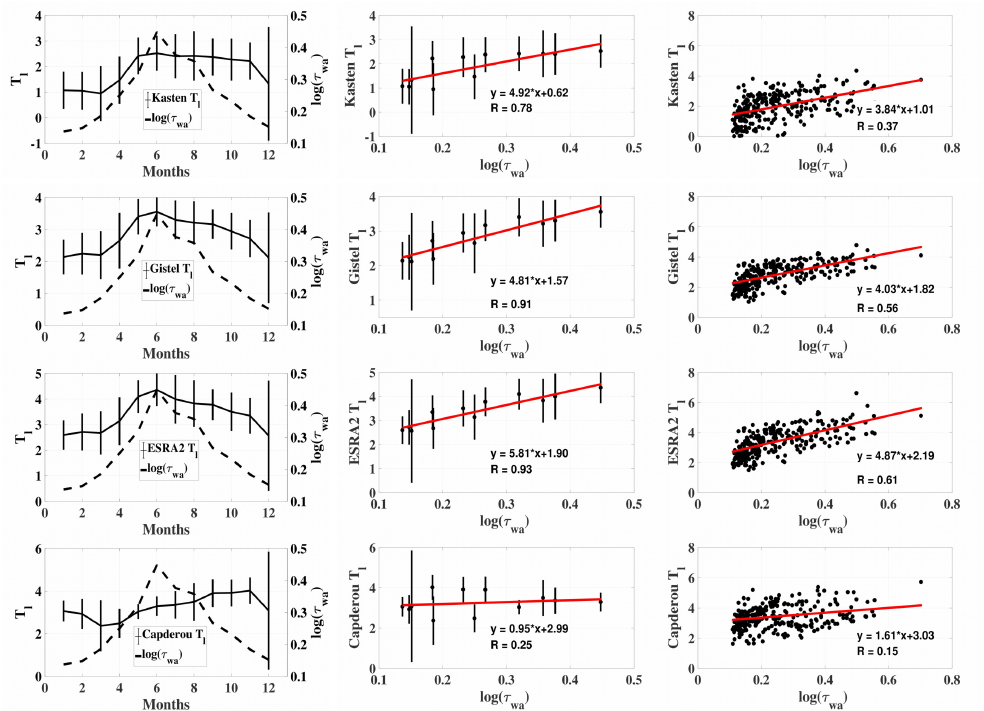
Figure 6. Left plots: monthly average values of both the Linke turbidity (full line) and log ( τ wa ) (dashed line). Middle plots: correlation between the monthly average values of the Linke turbidity and log ( τ wa ) . Right plots: correlation between the daily values of the Linke turbidity and log ( τ wa )